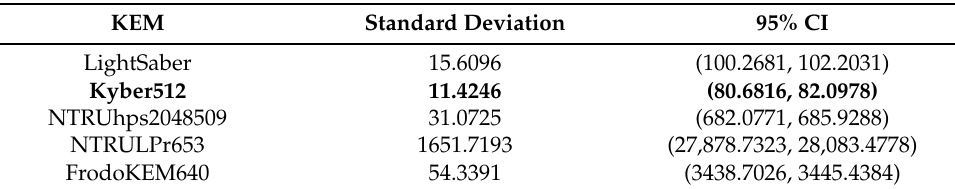
Table 7. The standard deviation and 95% CI values of CPU usage for the operation decryption , for each of the KEMs.